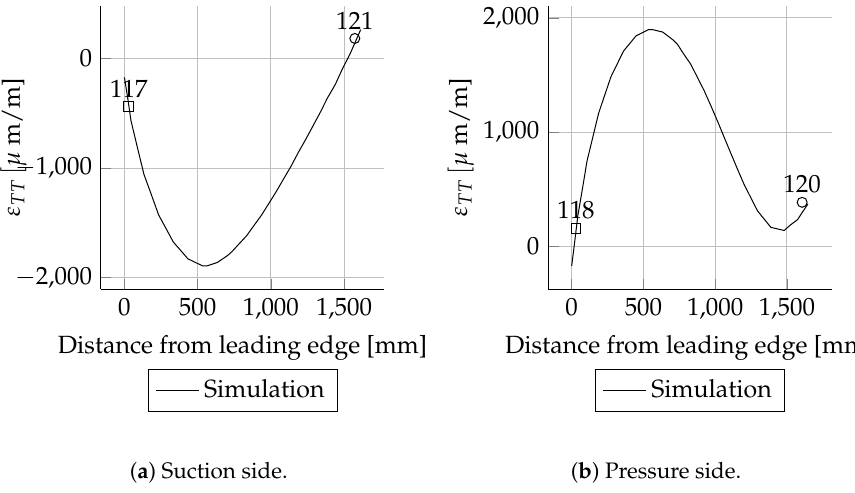
Figure A35. Strain comparison ε LL at radial position R = 11,000 mm for Mymax load